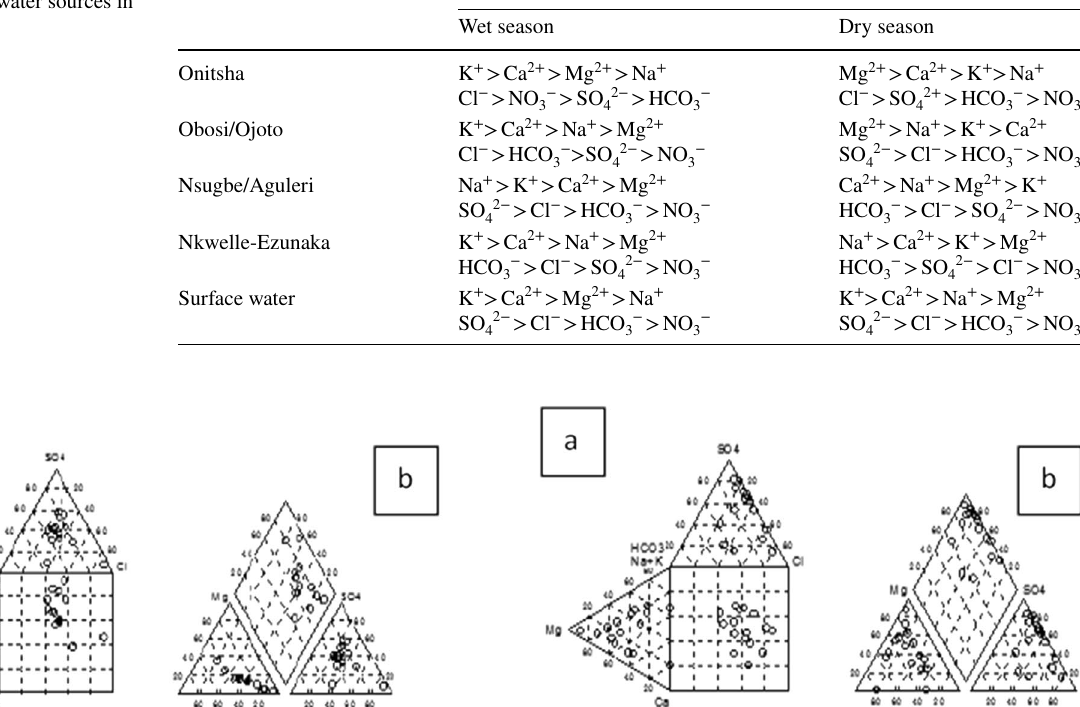
ionic species in water sources in the study area